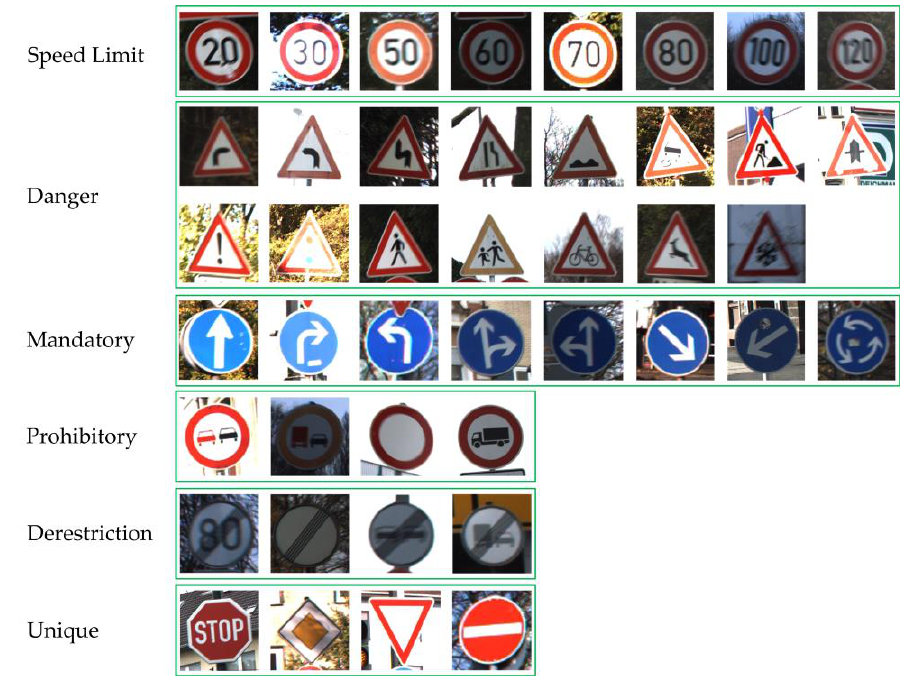
Figure 8. Six categories of traffic signs sample images.